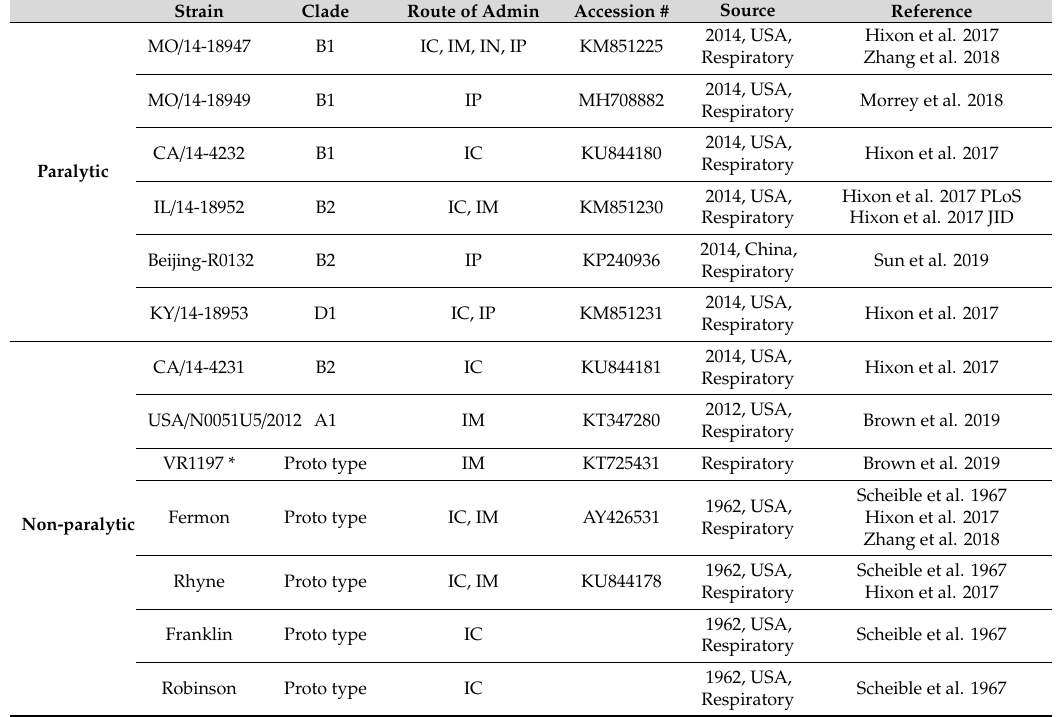
Table 1. Paralytic and non-paralytic enterovirus D68 (EV-D68) strains. Strain